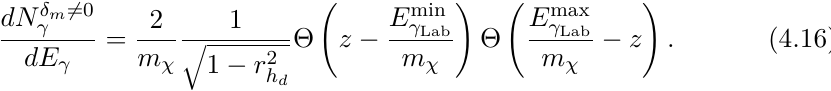
= 10 GeV , g = χ X = ( m ) /m = 0 . Right panel : 0 m χ − m χ Z = 10 − 3 m